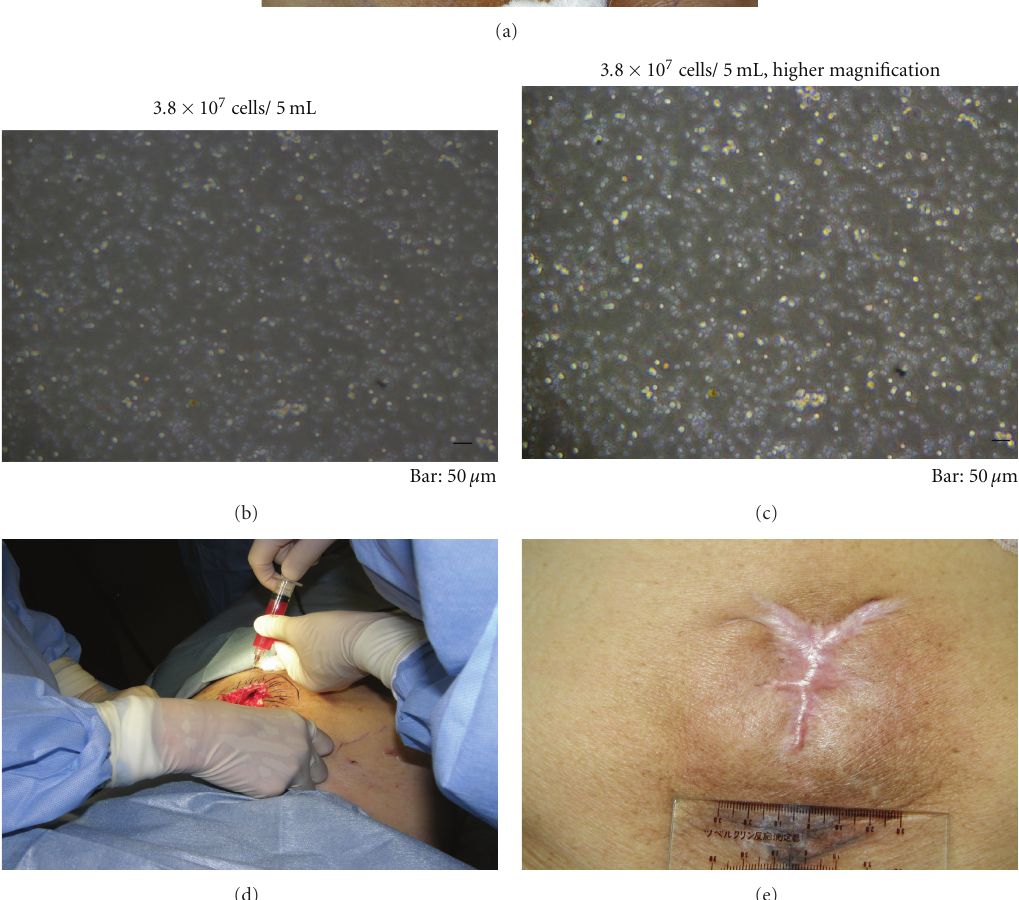
Figure 6: 89-year-old woman underwent a uterine cancer surgery followed by 50-Gy fractionate radiation therapy 40 years previously. (a) In 10 × 10 cm area of radiation, 5 × 10cm area was exposed. Bone, fascia, and muscle as well as skin and fat were a ff ected. (b, c, d) After careful debridement, 3 . 8 × 10 7 cells/5 mL were applied over the wound bed and margins and soaked with artificial dermis. In a few days postoperatively, bFGF was sprayed over the peeled-o ff inner regenerated tissue for 21 days. (e) In 1.5 years postoperative view. The regenerated tissue remained durable, soft, and